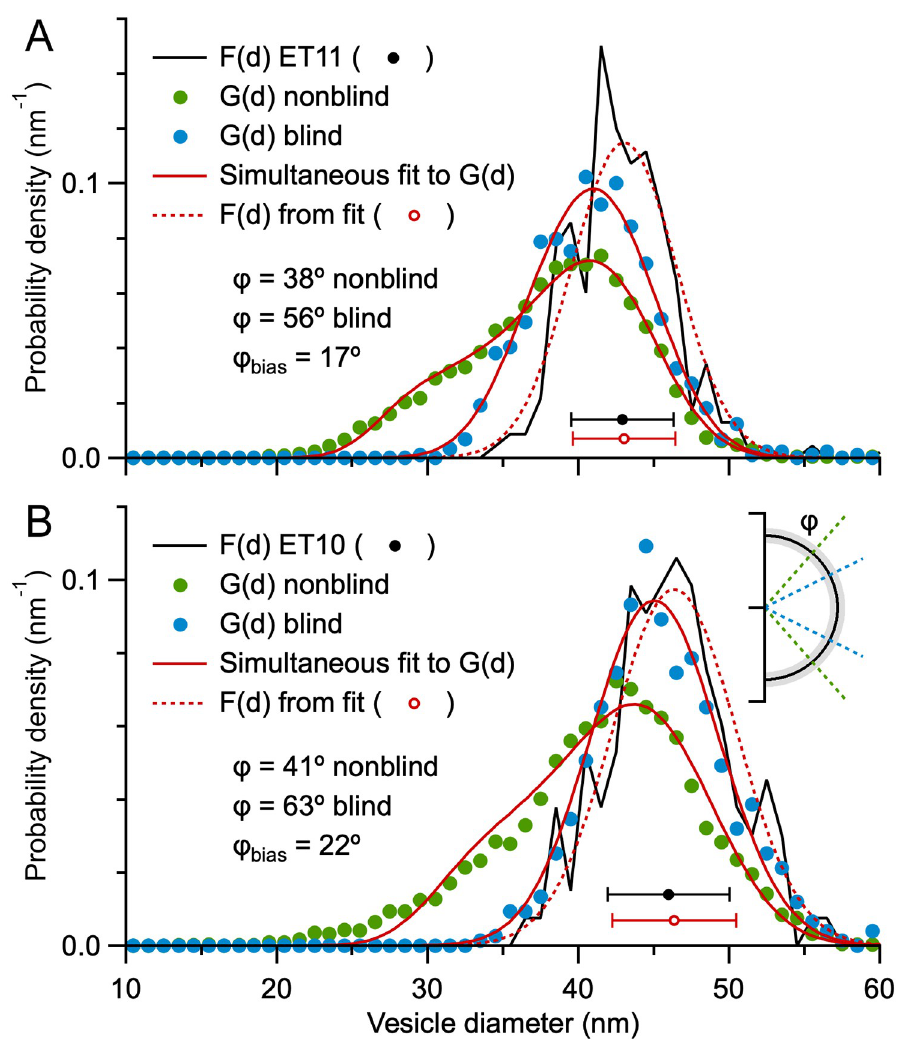
Fig 7. Comparison of G(d) computed blind versus nonblind reveals a large bias in particle cap detection for MFT vesicles ( ϕ bias � 20˚). A. Probability density of 2D diameters (G(d)) computed via a nonblind vesicle detection (green circles; ET11; Fig 6D) versus a blind vesicle detection (blue circles). Both G(d) were simultaneously curve fitted to Eq 1, where parameters μ D and σ D were shared, revealing a 17˚ bias in ϕ (red solid lines; μ D = 43.0 ± 0.1 nm, σ D = 3.5 ± 0.1 nm, nonblind ϕ = 38.3 ± 0.5˚, blind ϕ = 55.5 ± 0.7˚). As in Fig 6D, estimated F(d) (red dotted line and circle) is similar to measured F(d) (black solid line and circle). For the blind analysis, there were 889 diameters measured from 18 z- planes (z # = 1–260) spaced 5–15 nm apart, analysed in random order. B. Same as A for ET10 (S8D Fig in S1 File). The simultaneous curve fit revealed a 22˚ bias in ϕ (red solid lines; μ D = 46.4 ± 0.1 nm, σ D = 4.1 ± 0.1 nm, nonblind ϕ = 40.9 ± 0.7˚, blind ϕ = 63.3 ± 1.3˚). For the blind analysis, there were 751 diameters measured from 30 z-planes (z # = 51–236) spaced 2–7 nm apart, analysed in random order. Inset cartoon depicts the bias in ϕ along the axial axis of a vesicle.